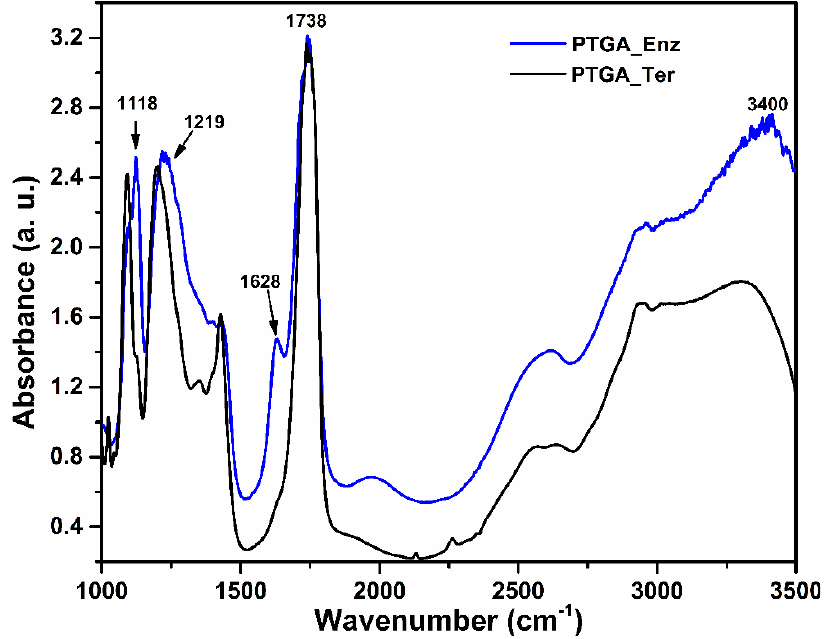
Figure 4. FTIR spectra of PTGA_Ter and PTGA_Enz collected between 400 and 4000 cm − 1 using 1.92 mg of the sample as pressed pellets embedded in KBr. 1.92 mg of the sample as pressed pellets embedded in